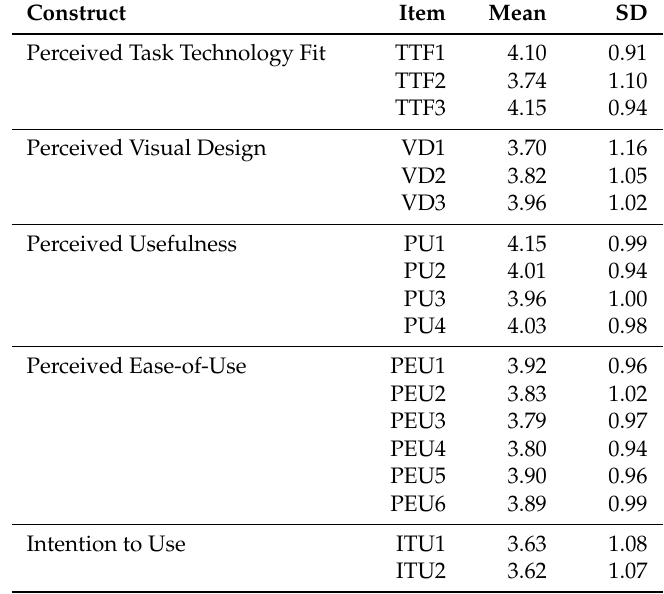
Table 3. Means and standard deviations of technology acceptance model measures (N =